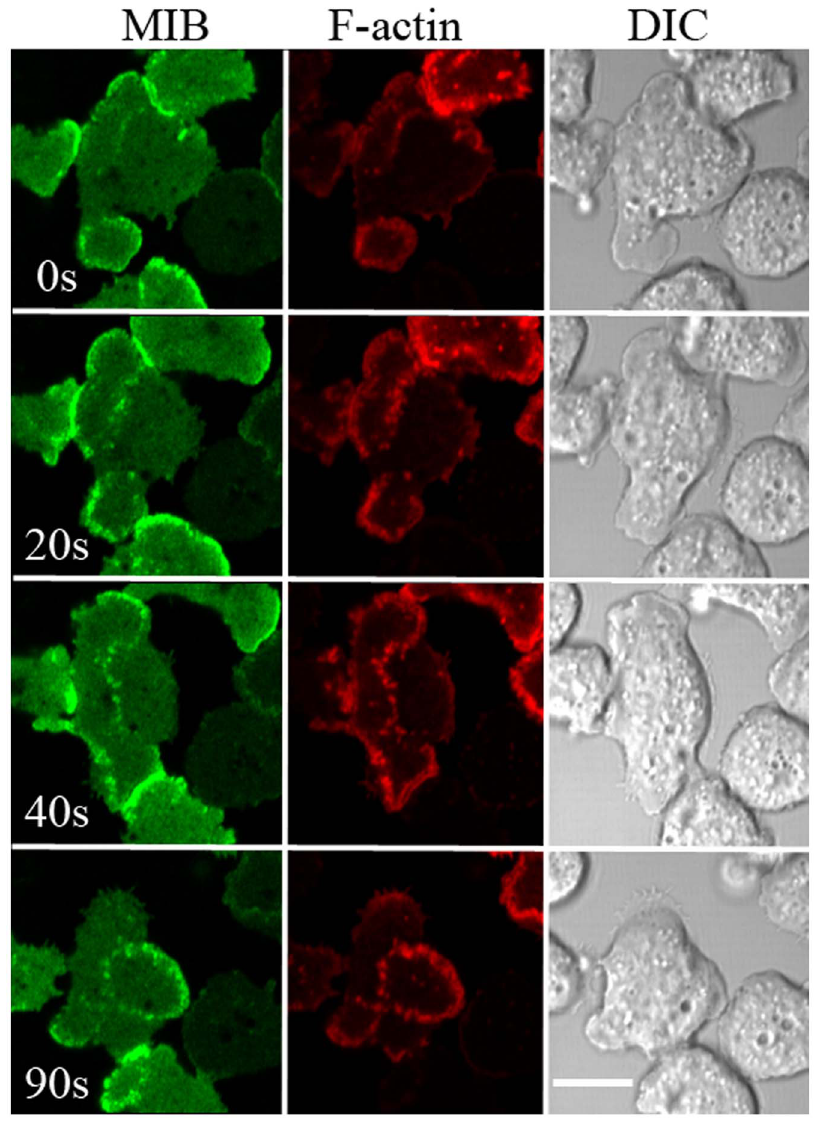
Figure 4. Co-localization of MIB and F-actin in waves; example of different shapes of actin waves formed in the same cells. myoB 2 - cells expressing mRFP-lifeact and GFP-MIB were starved for 30 min after which 1 m M latrunculin was added and cell images were recorded at the indicated times (seconds). 0 s corresponds to the beginning of the recording. Bar is 10 m m.